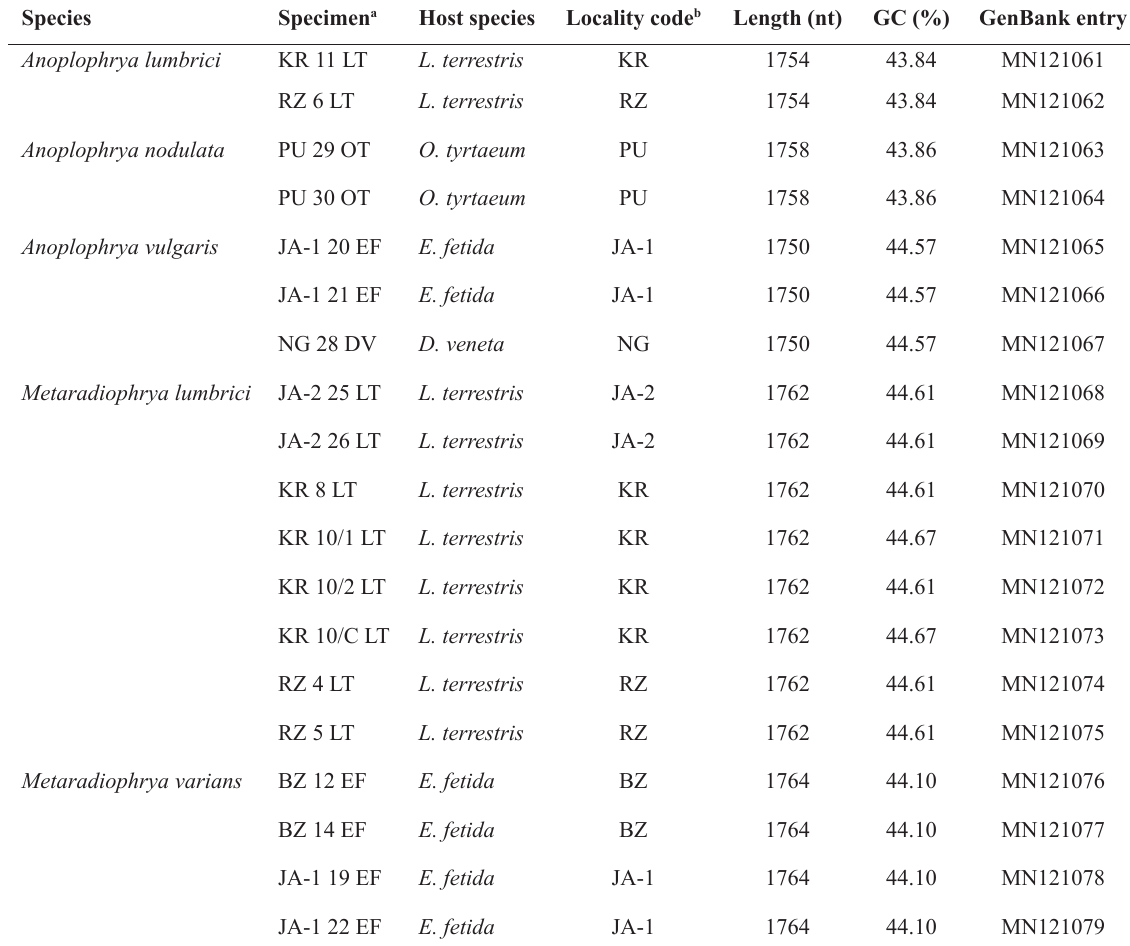
Table 4. Characterization of new 18S rRNA gene sequences of astome ciliates obtained from lumbricid